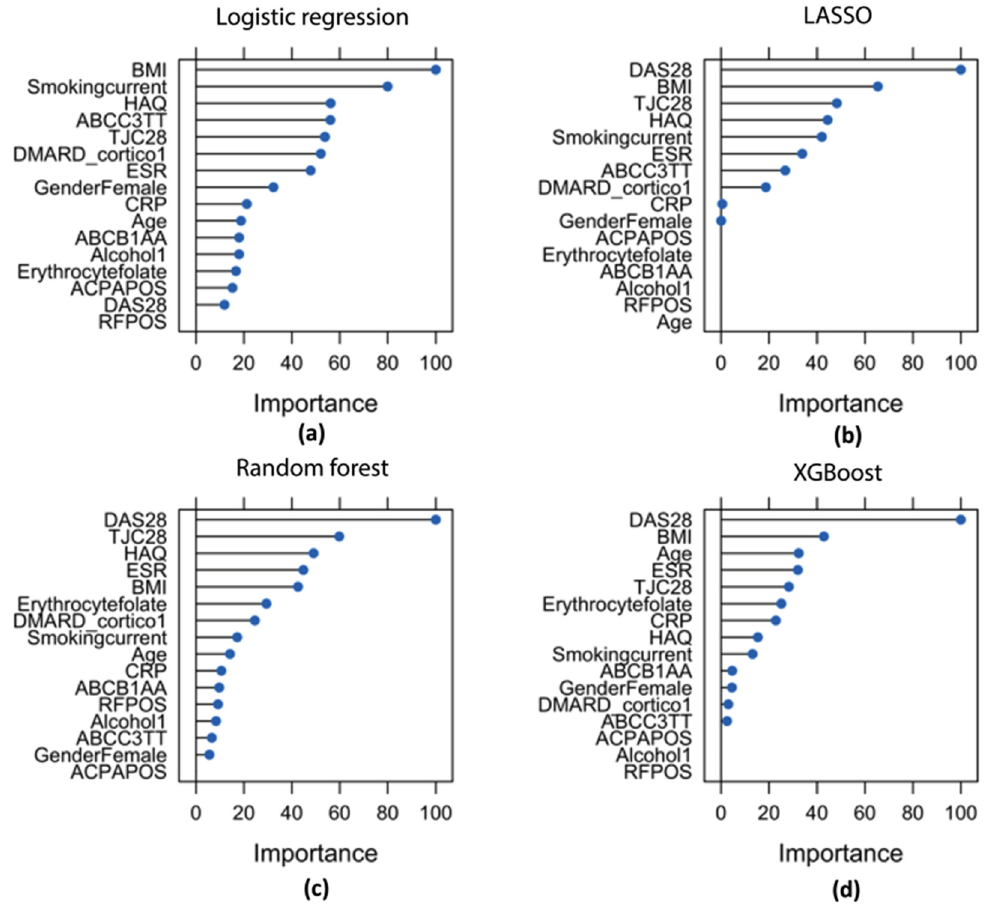
Figure 2. Feature importance plots of baseline features for ( a ) logistic regression, ( b ) LASSO, ( c ) random forest, and ( d ) XGBoost in the prediction of insufficient response at 3 months. Feature importance was determined based on regression coefficients (regression models) and the Gini score (RF and XGBoost) of final models. The most important feature was set to 100, and the rest is relative to that feature. Abbreviations: DAS28 = disease activity score 28, TJC28 = tender joint count 28, HAQ = Health Assessment Questionnaire, ESR = erythrocyte sedimentation rate, BMI = body mass index, DMARD_cortico1 = use of DMARDs or corticosteroids (0 = no, 1 = yes), Smoking (never/former versus current), CRP = c-reactive protein, ABCB1 AA vs. AG/GG, ABCC3 TT vs. TC/CC, RF = rheumatoid factor, Alcohol use (0 = 1 no, 1 = yes), ACPA = anticitrullinated protein (positive versus negative).